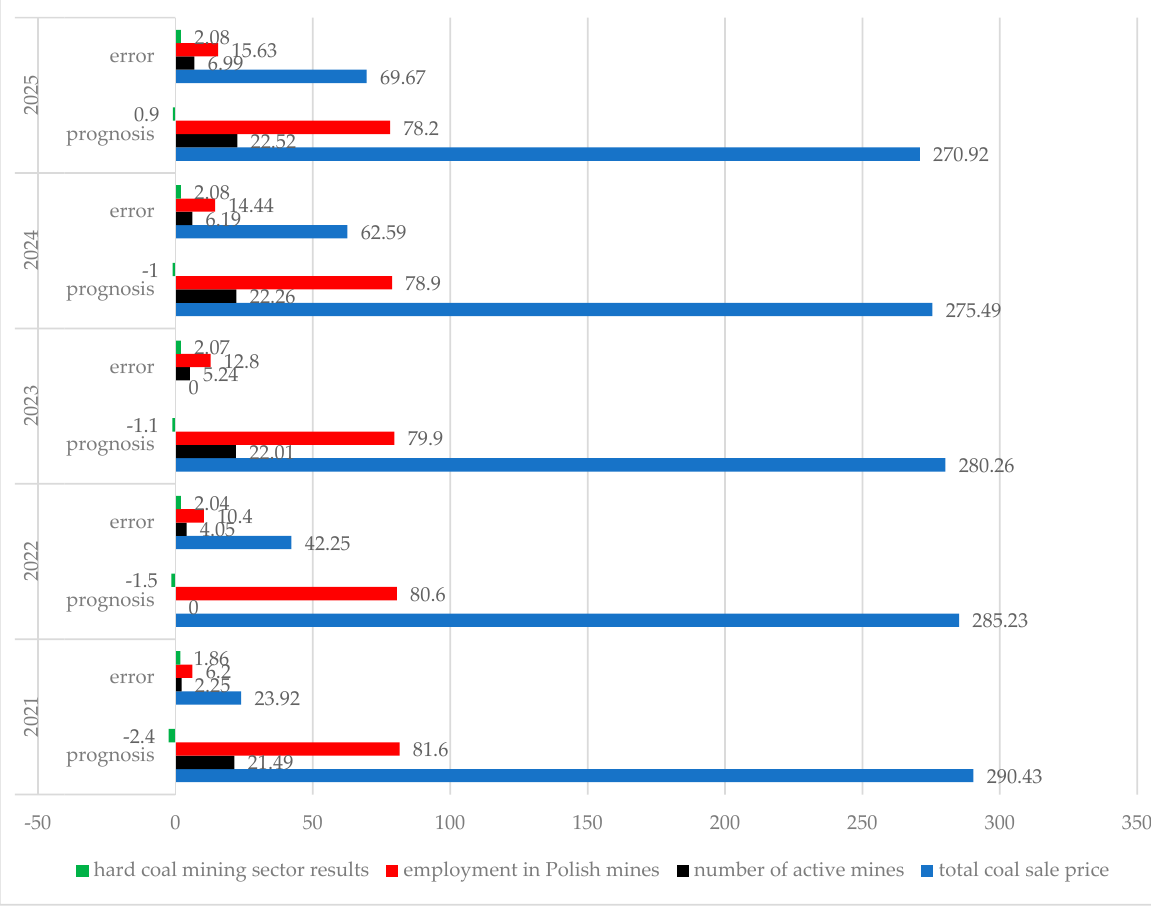
Figure 3. Prognosis and errors of analyzed variables. Source: own analysis.